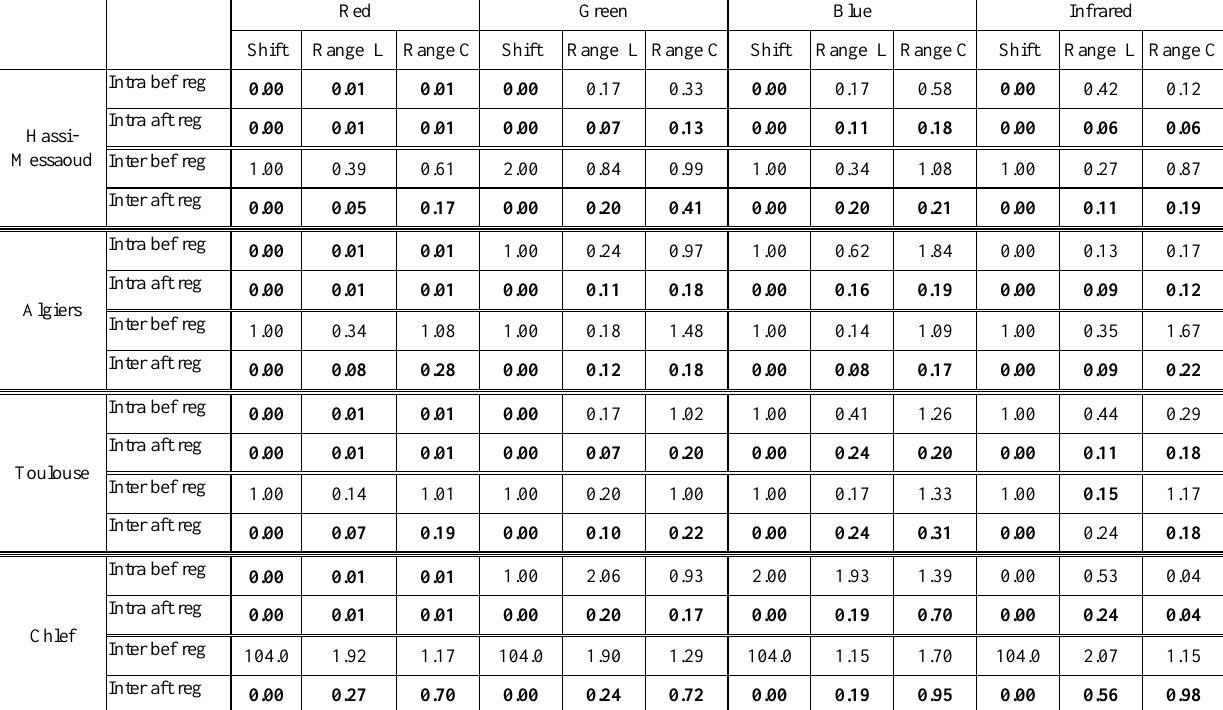
Table 2. Registration error (in Pixel) for intra MS bands and inter (PAN as reference with MS bands) before and after the application of the proposed